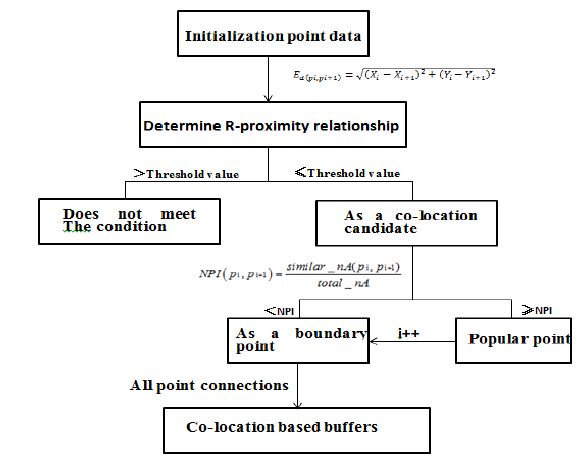
Figure 2. Irregular point buffer implementation process Spatial coordinates are important parameters for spatial analysis.